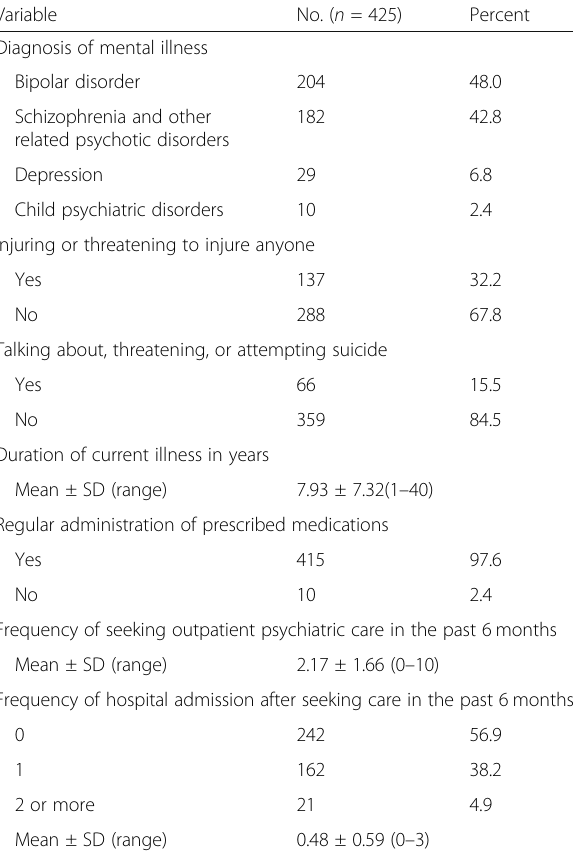
Table 2 Mental condition of the studied mentally ill